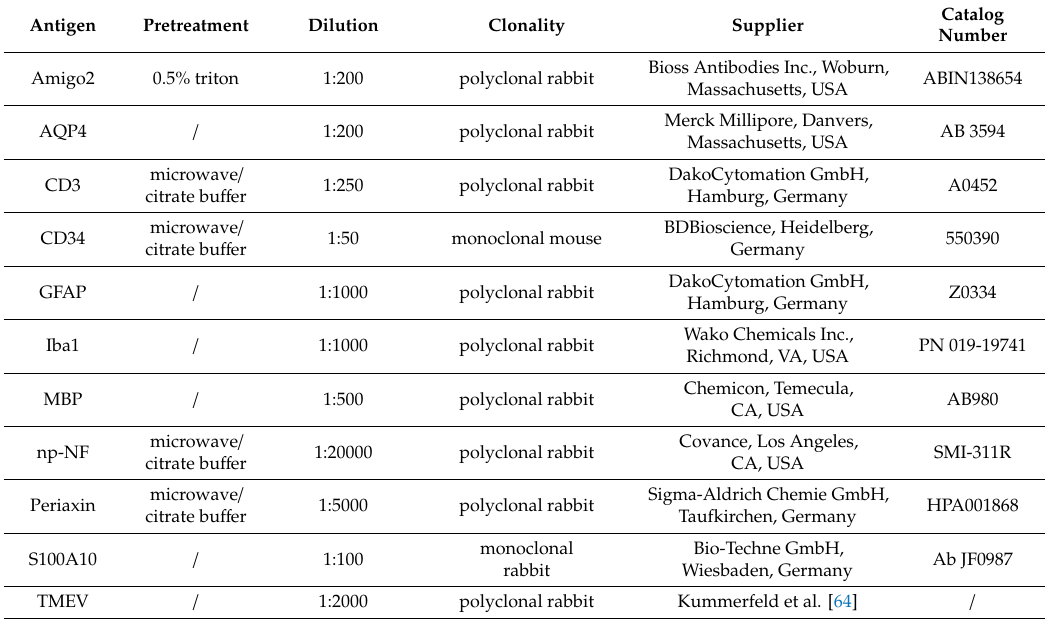
Table 1. Primary antibodies, pretreatment, and dilutions used for